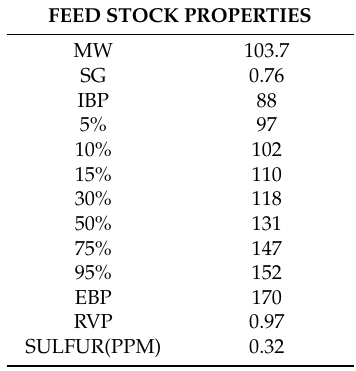
Table 8. Feed Properties KRPC Commercial Catalytic